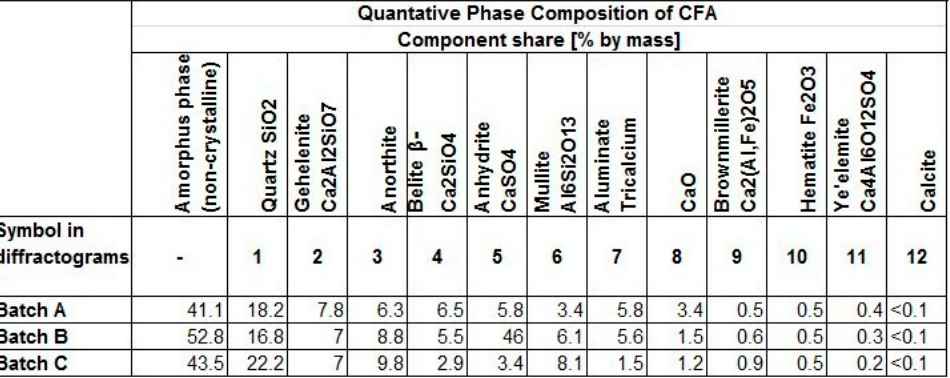
Figure 1. The X-ray diffraction (XRD) pattern of CFA batch A, B, C.